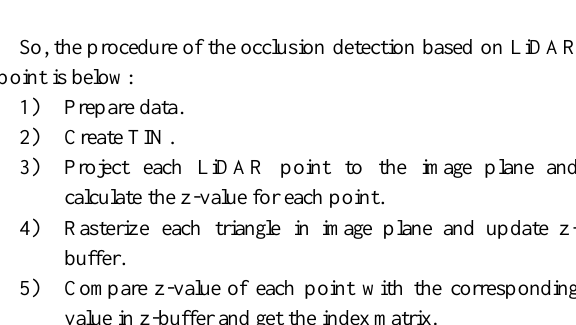
Figure 2. Rasterization of triangle